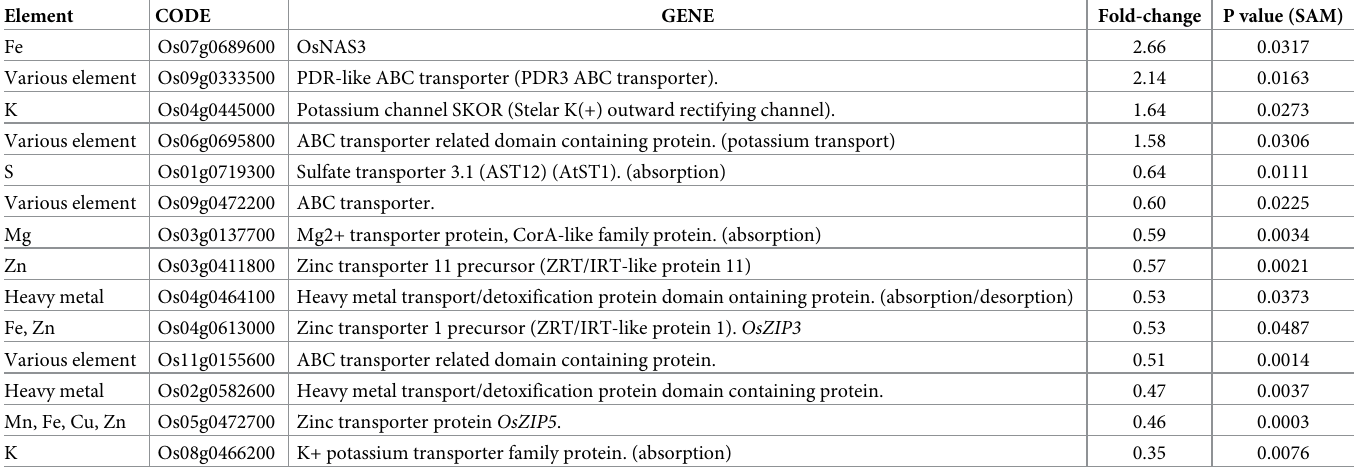
Table 2. List of genes for element transport that is affected by elevated [CO 2